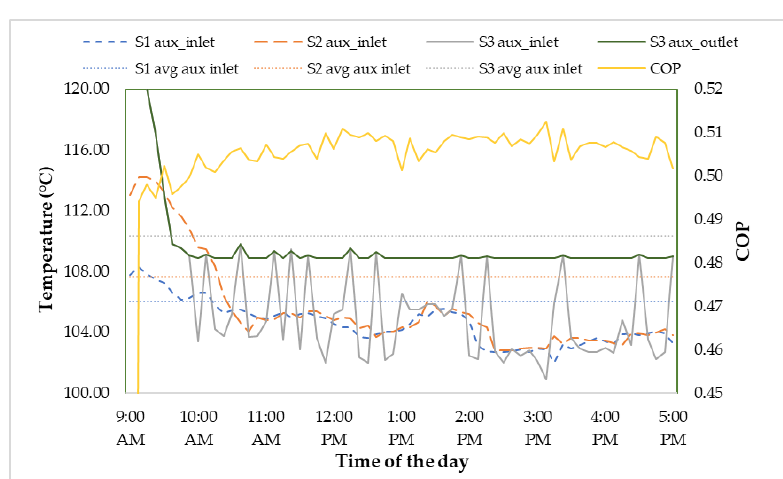
Figure 13. Chiller COP and inlet/outlet temperature profile for auxiliary heater for the mid-day of